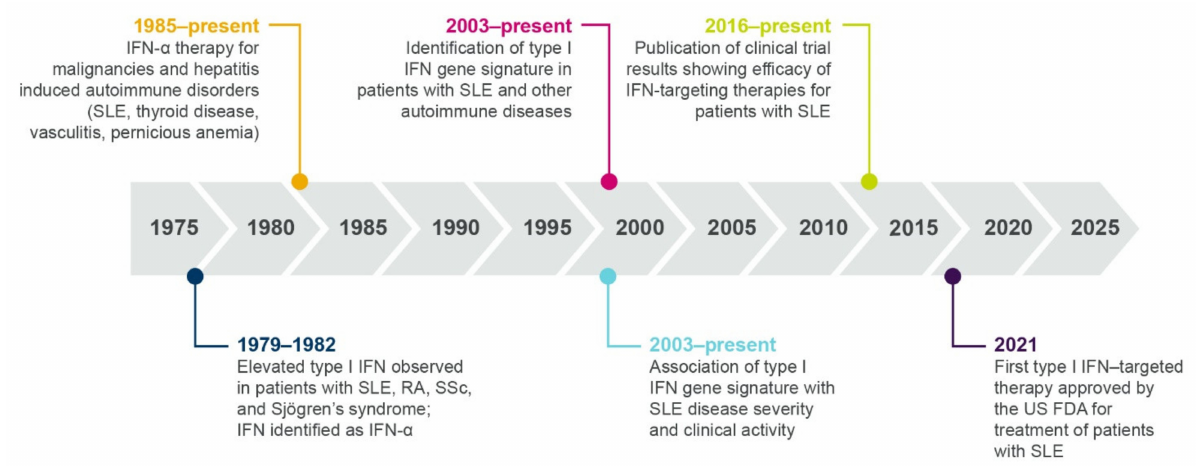
Figure 3. Timeline showing multiple lines of evidence that support the role of type I interferon in SLE and autoimmune pathogenesis. IFN, interferon; RA, rheumatoid arthritis; SLE, systemic lupus erythematosus; SSc, systemic